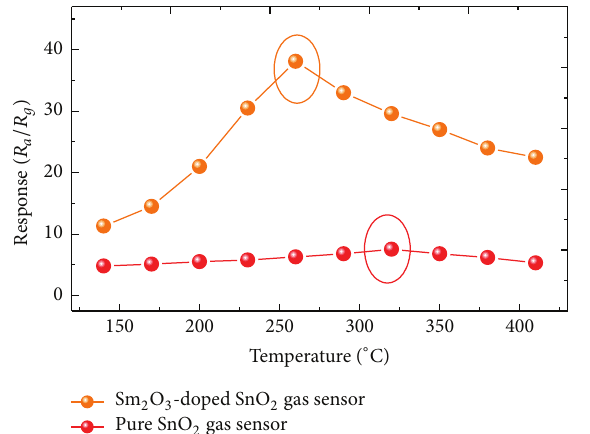
Figure 10: Reproducibility of the Sm 2 O 3 decorated SnO 2 nanorods sensor to 20 𝜇 L/L of C 2 H 2 at 260 ∘ C.